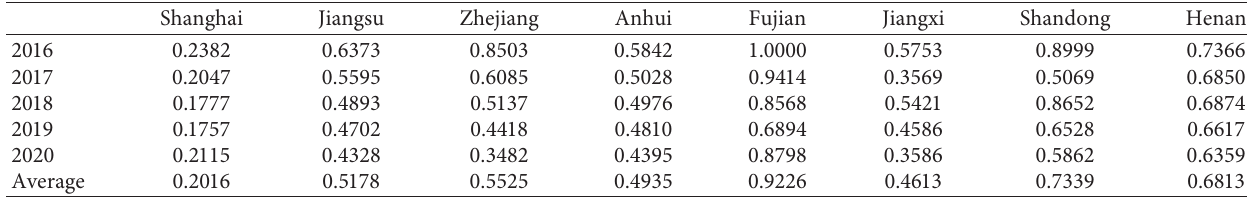
Table 2: Performance evaluation values of the system for workers in the eastern region.